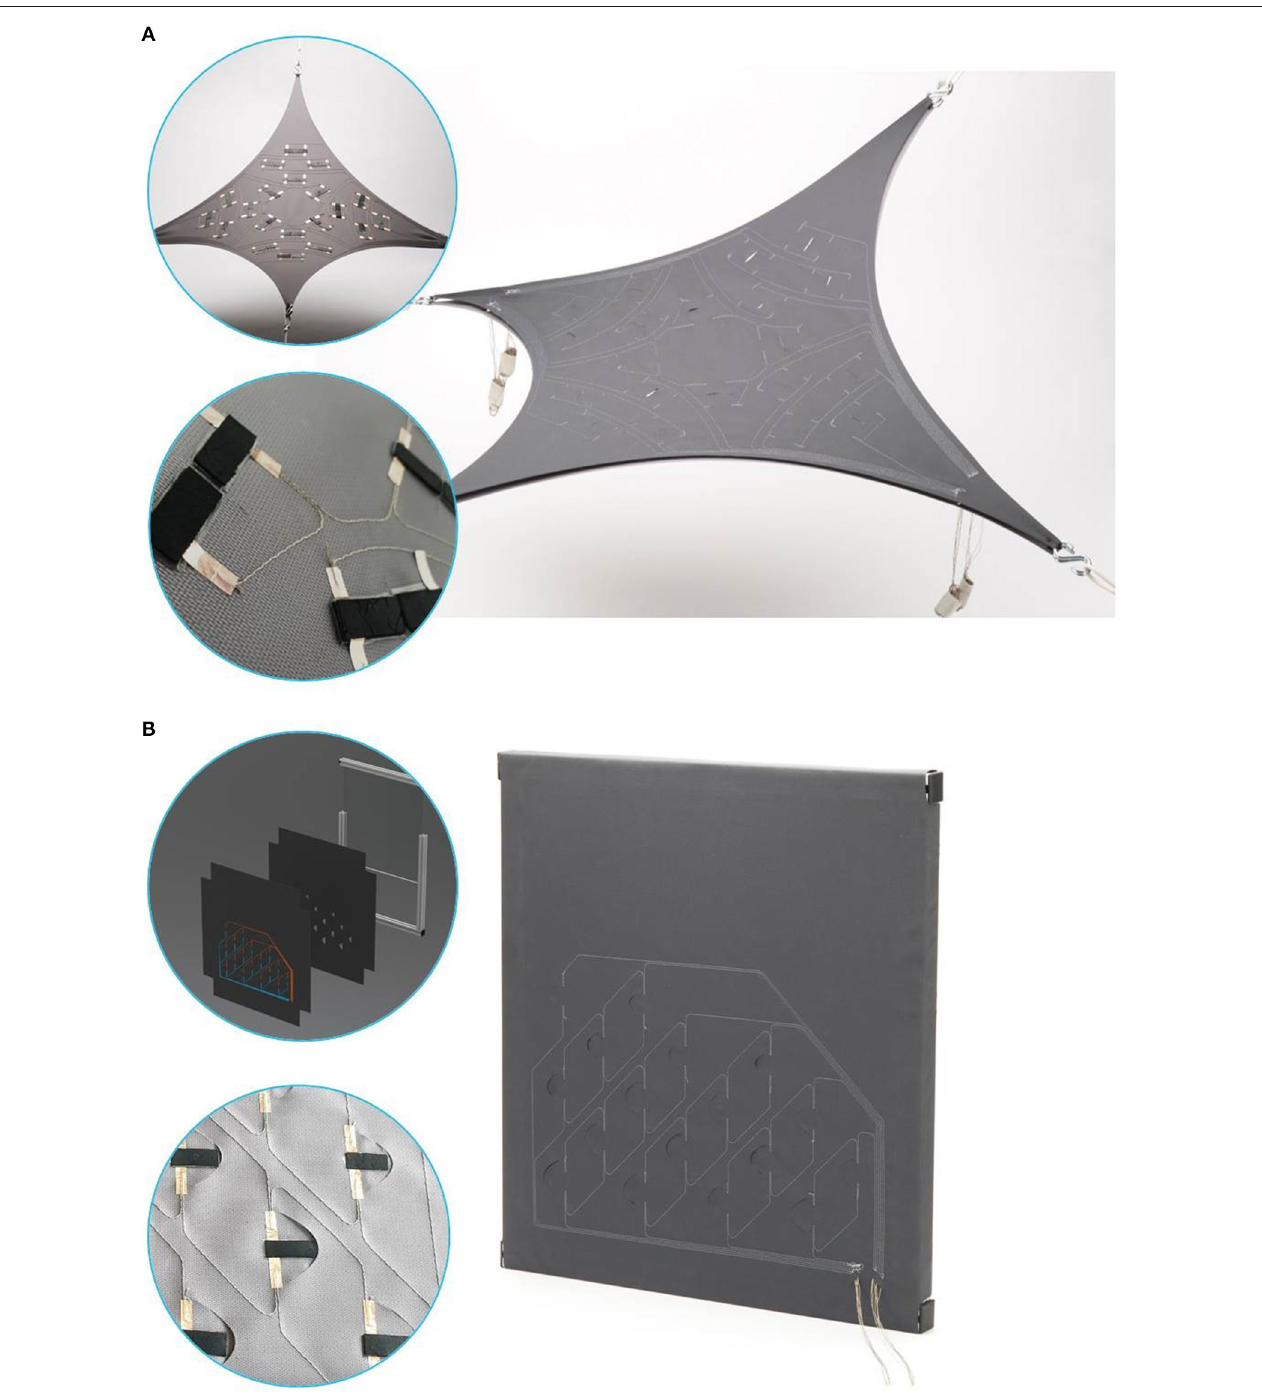
FIGURE 11 | Final demonstrators: (A) double-curved 2-layer membrane element with controllable apertures actuated by CNT actuators. (B) Planar membrane demonstrator with controllable flaps having both actuator and sensor functionalities through integrated CNT actuators.